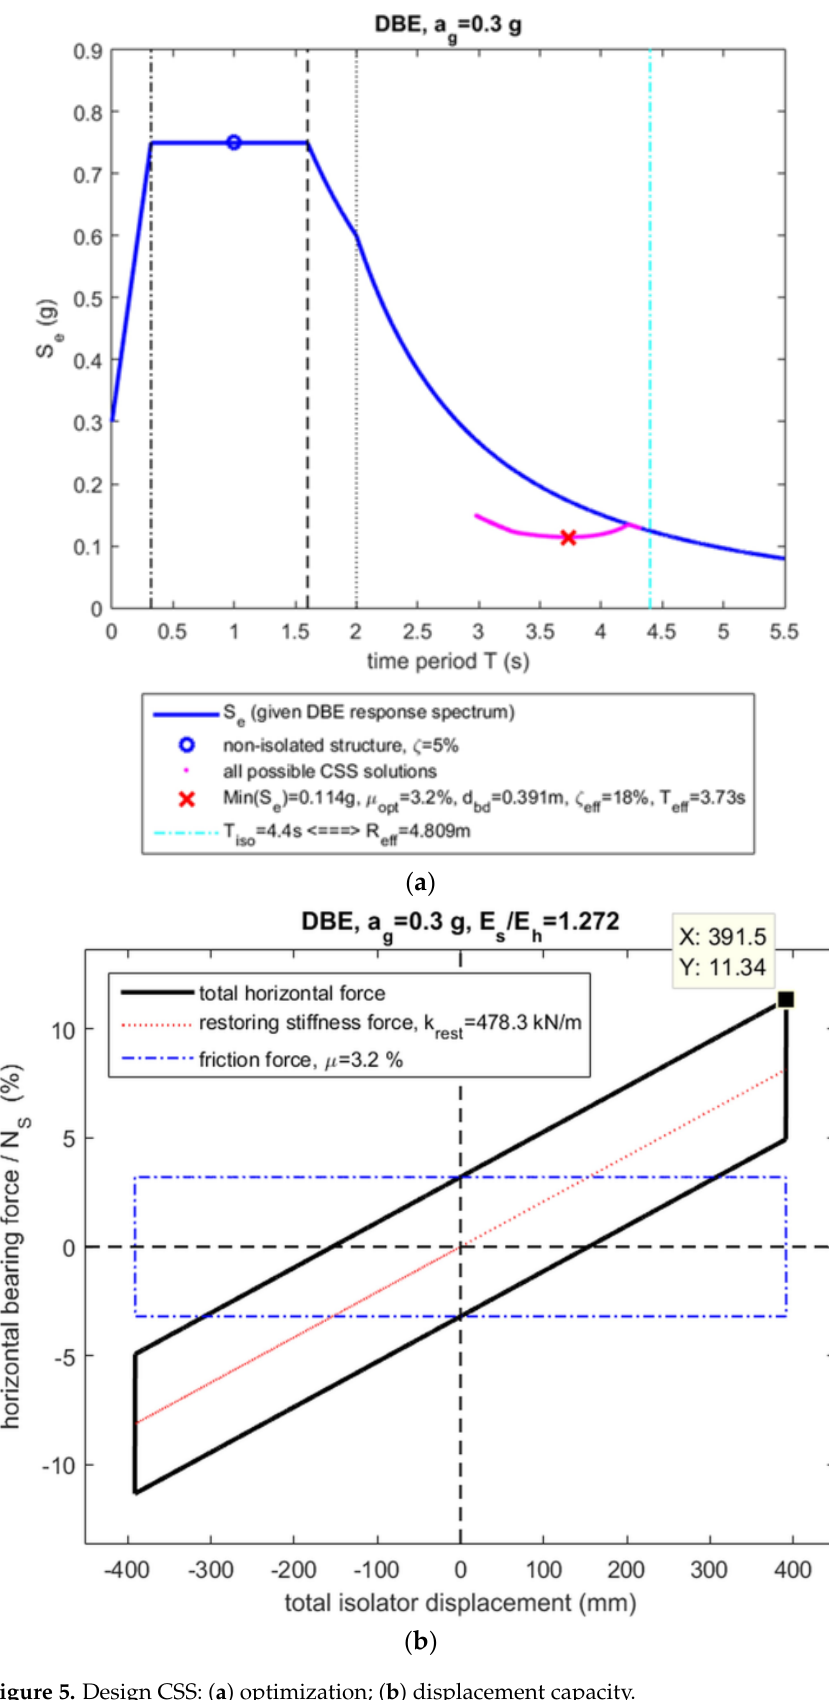
Figure 5. Design CSS: ( a ) optimization; ( b ) displacement capacity.